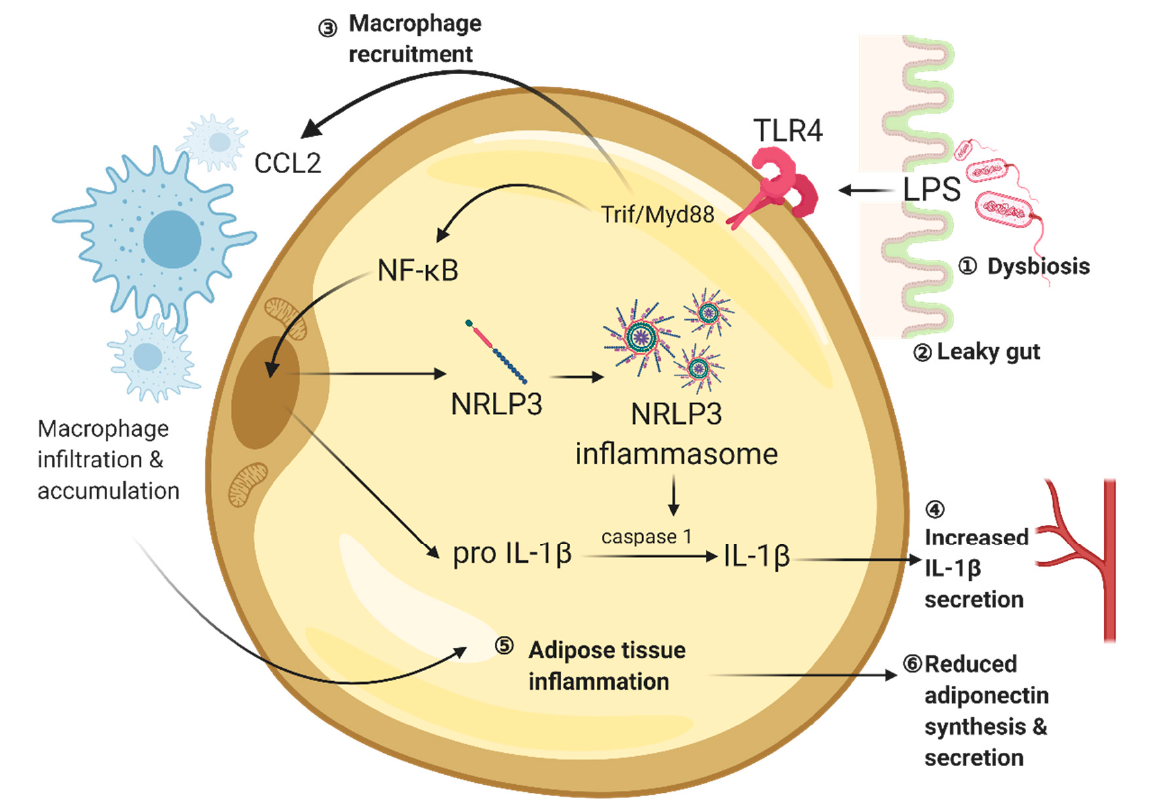
Figure 1. The high-fat diet promotes gut dysbiosis and adipose tissue inflammation. ① The chronic high-fat diet consumption upset the gut microbiome with an increased ratio of gram-negative bacteria to gram-positive bacteria. ② Endotoxemia reduces endothelium integrity, which allows the leakage of endotoxin, such as lipopolysaccharides. ③ LPS-induced activation of TLR4/Trif/MyD88 promotes macrophage recruitment through the secretion of CCL2. ④ Meanwhile, the activation of TLR4 also promotes NRLP3 and pro IL-1 β syntheses, facilitating caspase 1-mediated IL-1 β formation. ⑤ In obesity, adipose tissue macrophages further infiltrate and accumulate in the fat tissue results in chronic, low-grade inflammation, while ⑥ adiponectin synthesis and secretion are reduced. Created with BioRender.com.